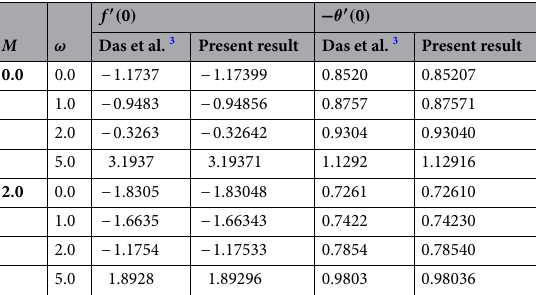
Table 3. Comparison of result f ′ ( 0 ) and a 0, and Pr k 1 k 2 c = = = =